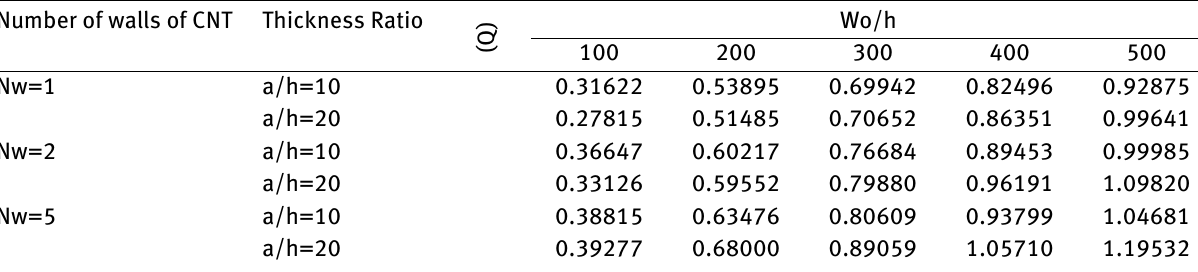
Table 4: Effect of various lamination scheme on transverse central deflection of SWCNTRC sandwich beam Number of walls of CNT